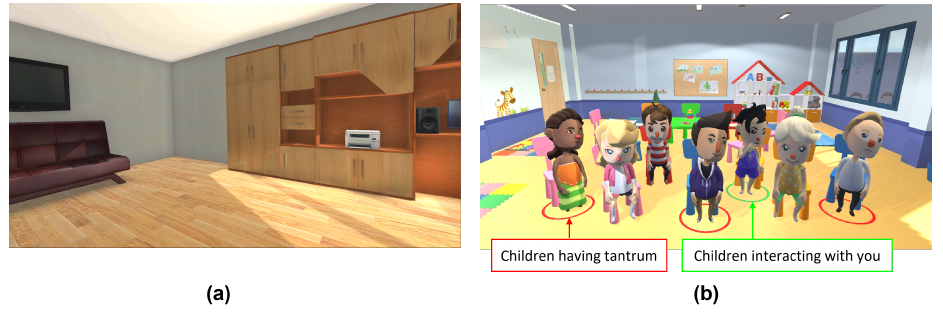
Figure 2. View of virtual environment for: ( a ) Enclosed room during resting with eyes open; ( b ) Class- room during mental